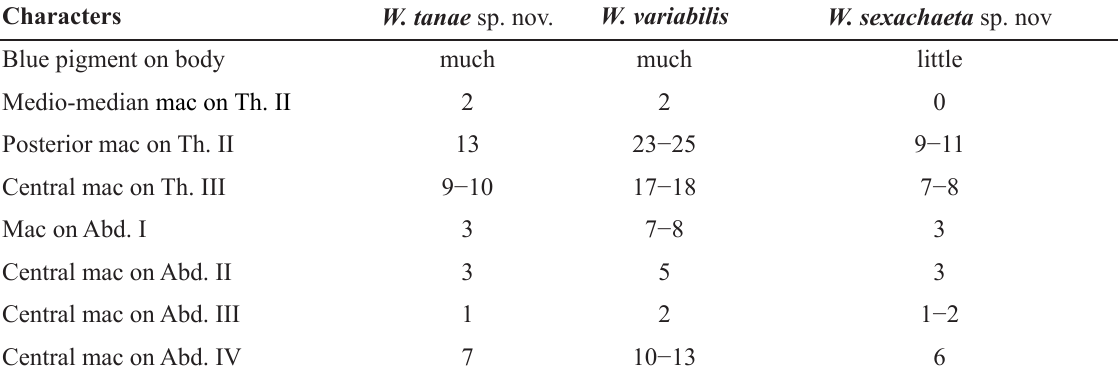
Table 4. Comparison of Willowsia. tanae sp. nov., W. variabilis Ma, 2016 and W. sexachaeta sp. nov